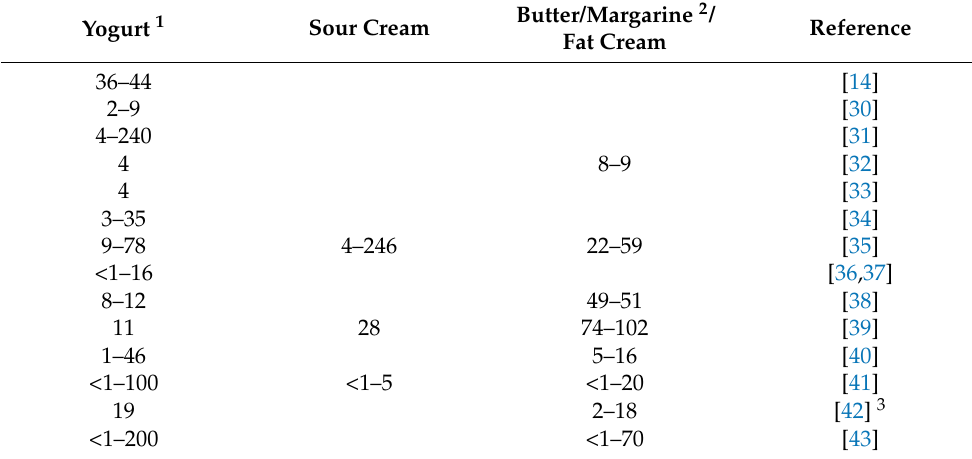
Table 1. Levels of styrene ( µ g/kg) in yogurt and other dairy products packed in PS from retail reported in literature as mean or range